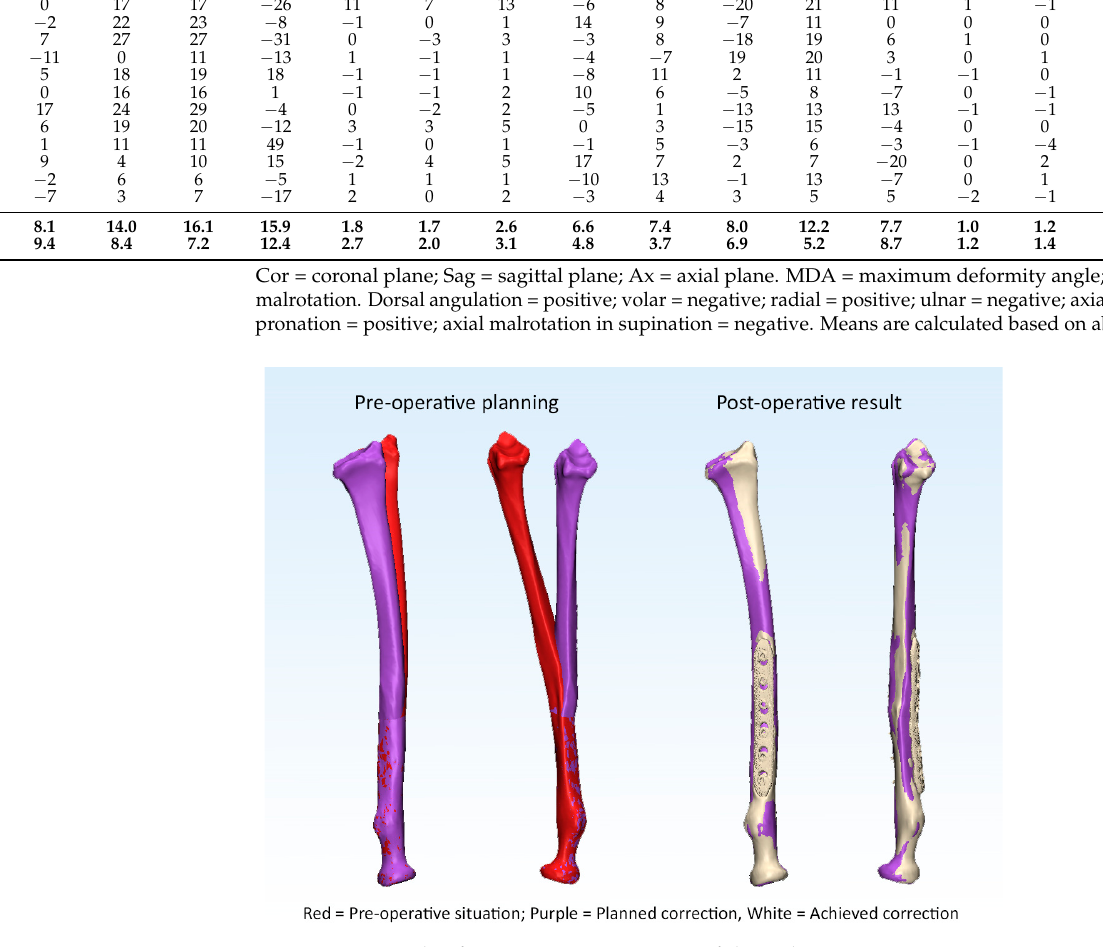
Figure 4. Example of a non-anatomic correction of the radius. Figure 5. Example of residual malrotation of the radius. 3.2. Is Anatomic Correction Associated with Greater Functional Outcomes?